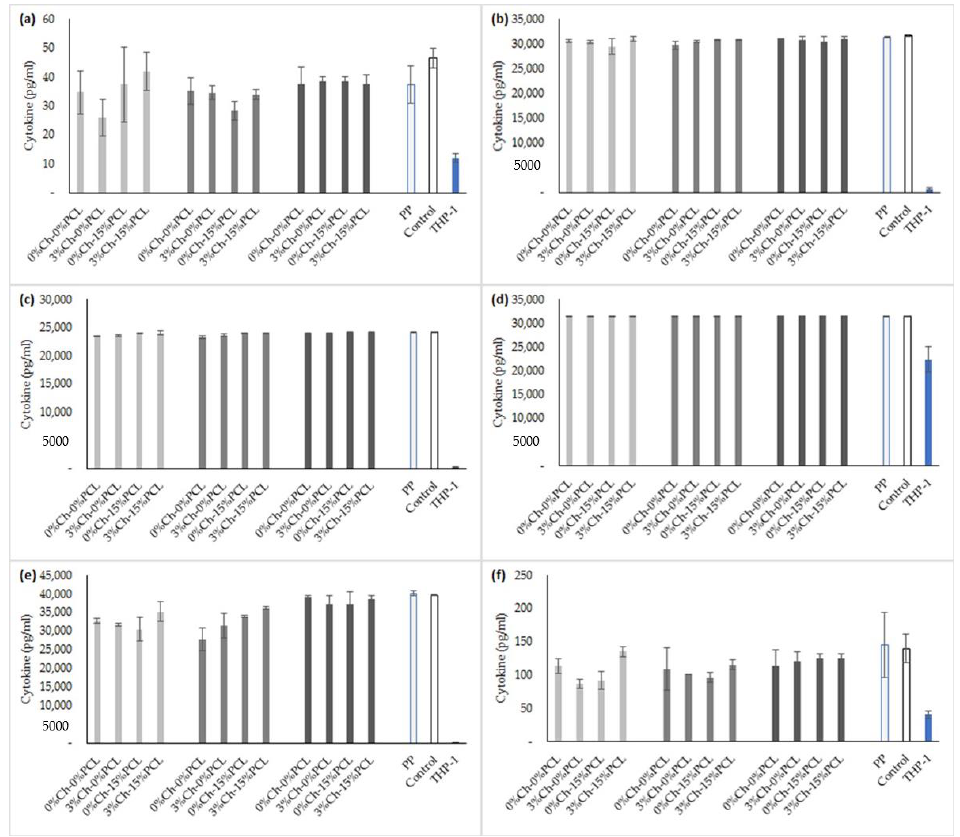
Figure 16. Pro-inflammatory cytokines without LPS stimulation. ( a ) INF-γ; ( b ) TNF-α; ( c ) IL-1β; ( d ) IL-8; ( e ) IL-6; ( f ) IL-2. PP: polypropylene as a reference material; Control: culture medium without PUs; THP-1: monocyte cell line. The concentration of cytokines is expressed as the mean ± SD (n = 3).